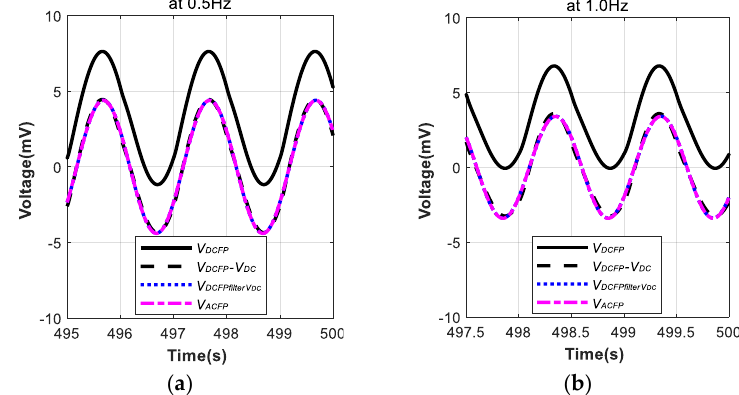
Figure 4. Steady-state AC fundamental voltage responses of both DC equivalent first principle linear circuit ( FPLC DCequ ) and AC equivalent first principle linear circuit ( FPLC ACequ ) are equal in simulations: ( a ) 5A rms current injections at 0.5Hz; ( b ) 5A rms current injections at 1.0 Hz.